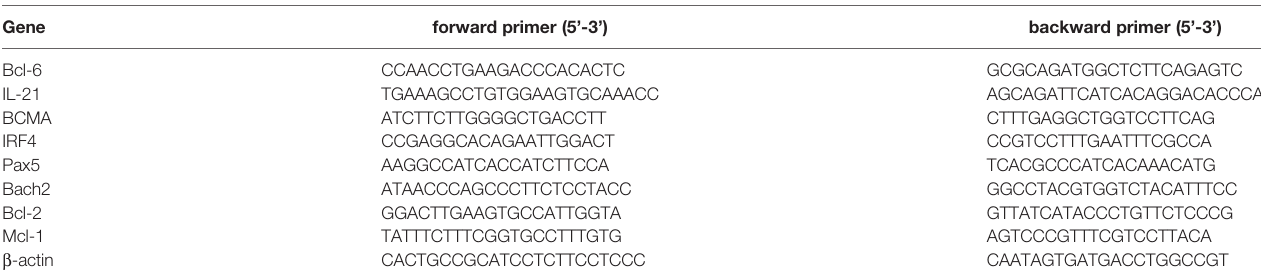
TABLE 1 | Primer sequences used for real-time